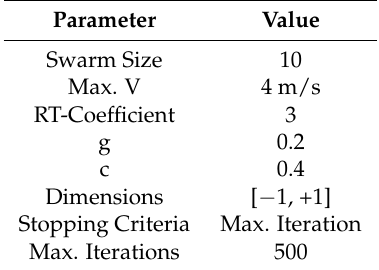
Table 12. WDO parameters and